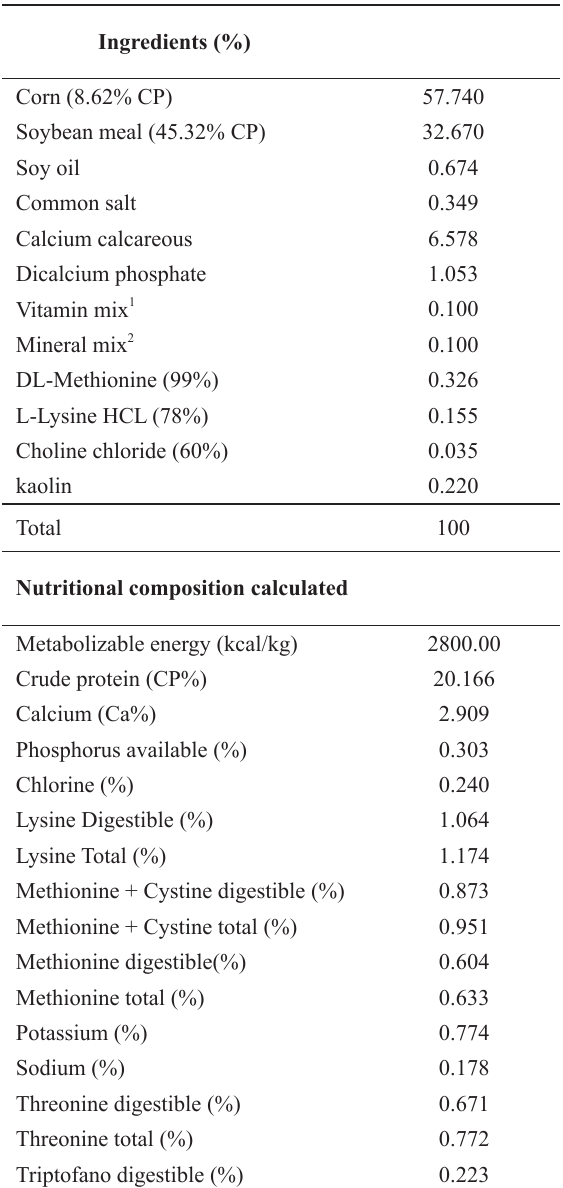
Percentage and calculated composition of experimental reference diet for Japanese quails in the production